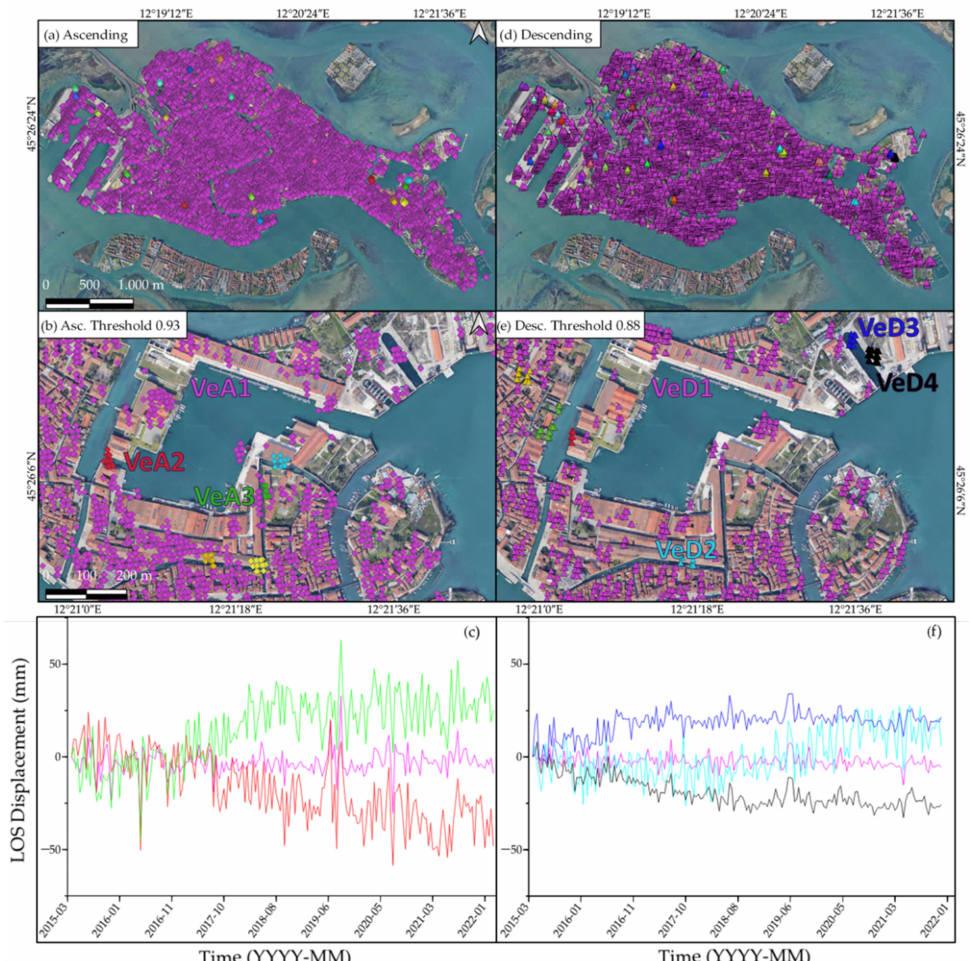
Figure 13. In ( a , d ) the subdivision of families of Venice at smaller scale. In ( b , e ) a further zoom showing the main family and a series of smaller ones corresponding to single or small groups of edifices. In ( c , f ) the time-series of the identified families within the close-up are